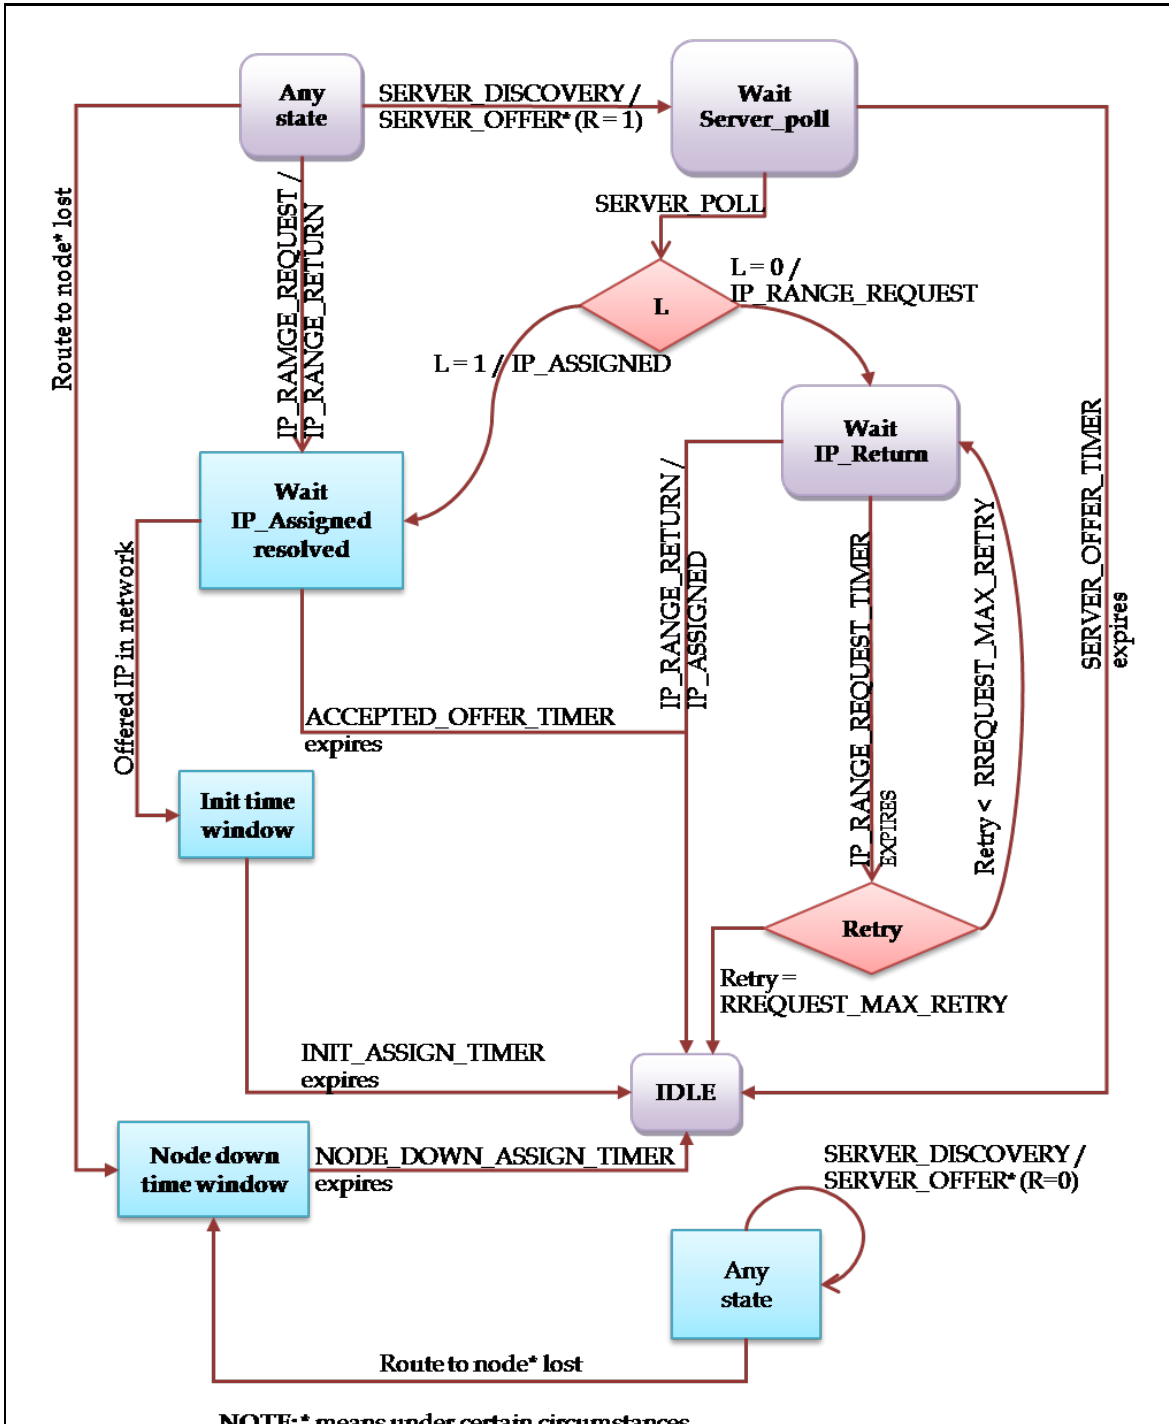
Figure 9. Server Node State